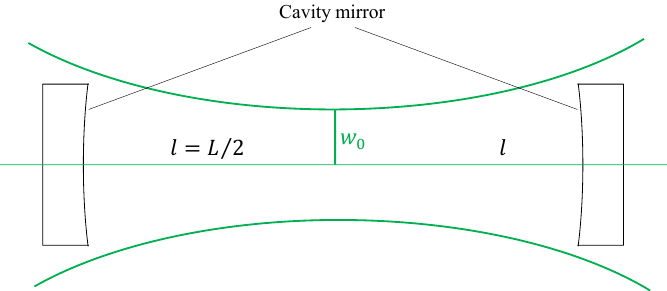
Figure 5. Detailed configuration of a FP cavity in DECIGO. Each FP cavity is shared by two interfer- ometers. The input and end mirrors are identical; that is, this FP cavity is symmetrical with respect to its beam waist point. The green horizontal line represents the optical axis of laser light. Additionally, the green curve shows the light